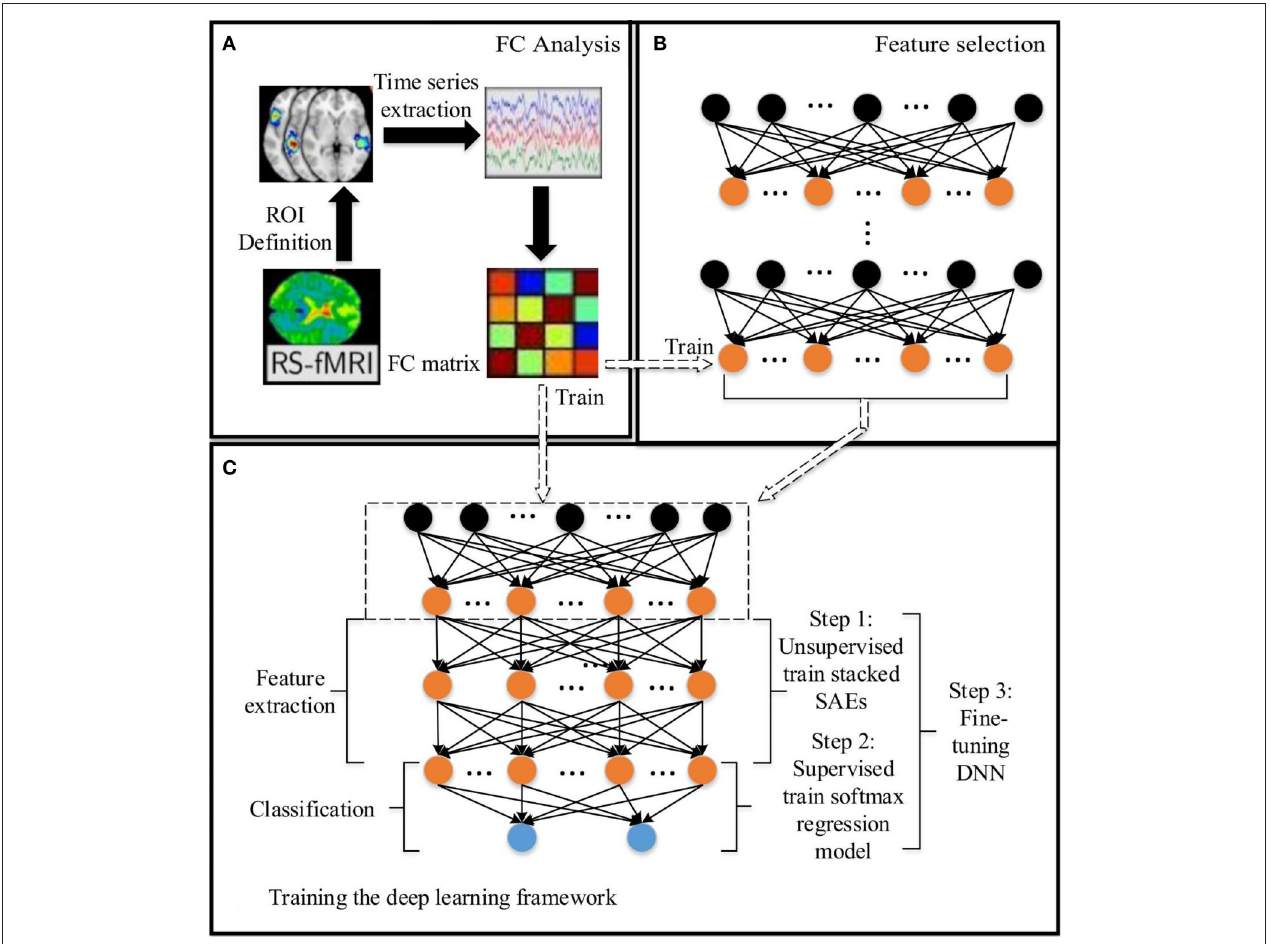
FIGURE 1 | The DNN based method for predicting the ASD: (A) Functional connectivity (FC) analysis. (B) Feature selection based on SAEs. (C) Training the DNN. The dashed arrow between (C) and (B) indicates that the low level SAE in (C) comes from (B) . Arrows between (A) and (B) , (A) and (C) indicate the data flow between